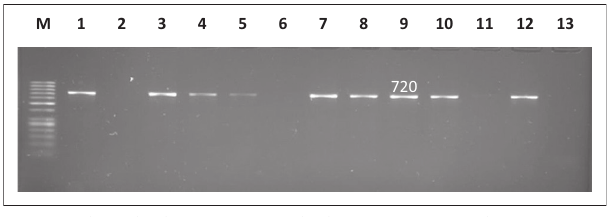
FIGURE 12: Detection of the 720 bp sul 2 gene amplicon from eight representative Salmonella isolates by agarose gel